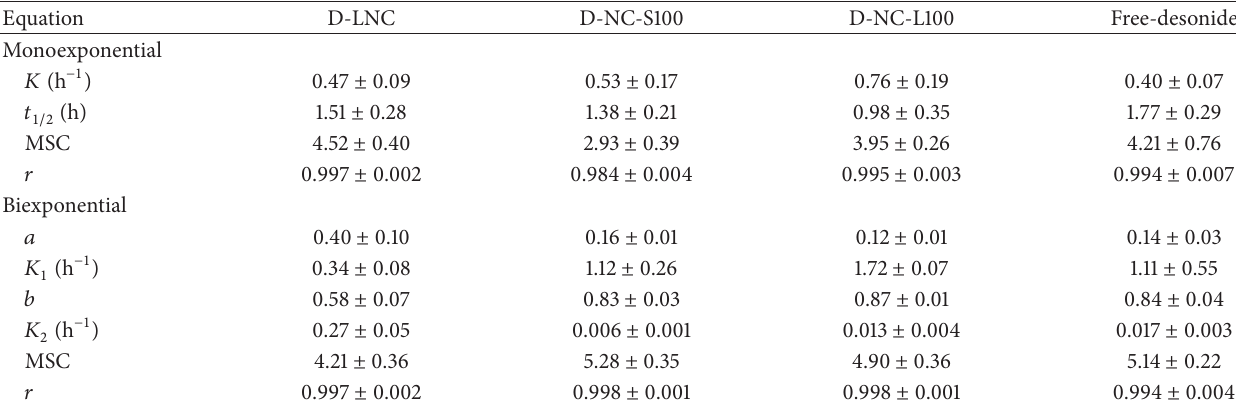
Table 5: Release constants, correlation coefficients, and MSC obtained by fitting the release profiles of desonide using dialysis sac, according to the monoexponential and biexponential equations.